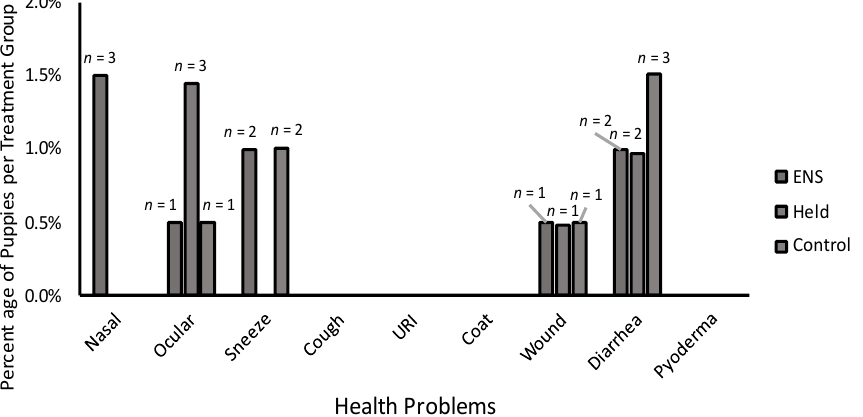
Figure 3. Percentage of puppies in each treatment group (ENS, held, and control) showing each physical health problem measured across the first eight weeks of life prior to the application of